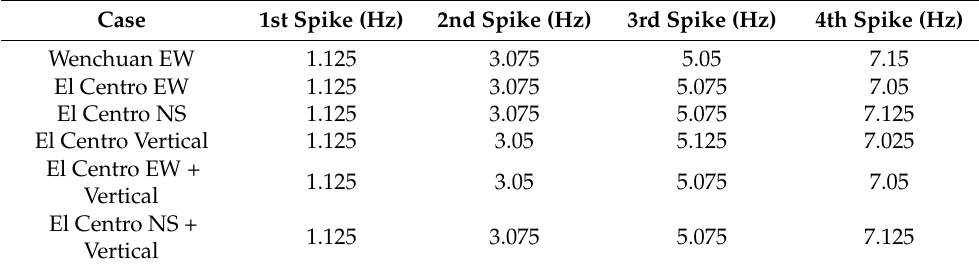
Figure 15. The fast Fourier transform of pressure time − series at the monitoring boundary points for different seismic excitations at the designed water level. Table 3. The frequency of the first four spikes in the frequency domain for all cases.